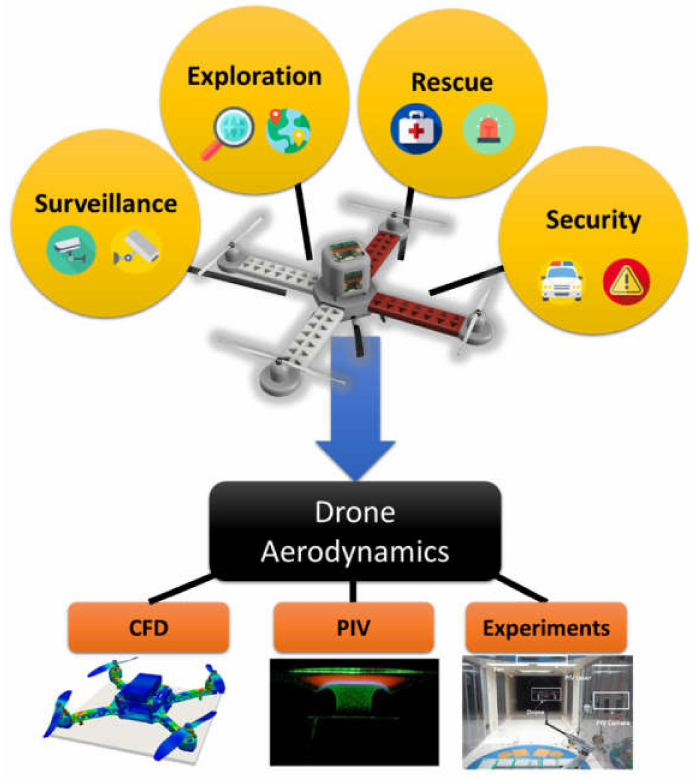
Figure 1. Drone development requires aerodynamic investigation by computational fluid dynamics (CFD), particle image velocimetry (PIV), and realistic